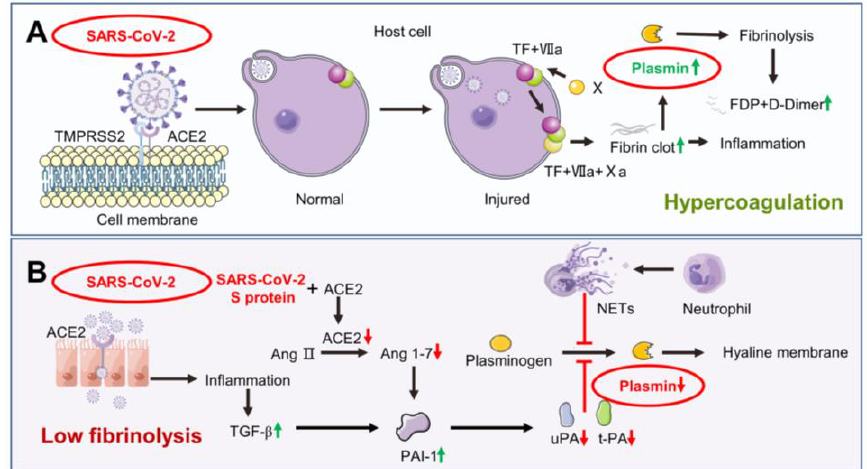
Figure 2. Possible process of coagulation and fibrinolysis in vivo during severe acute respiratory syn- drome coronavirus 2 (SARS-CoV-2) infection. ( A ) SARS-CoV-2 spike (S) protein binds to angiotensin- converting enzyme 2 (ACE2) receptors and facilitates virus invasion into host cells with the assistance of type II transmembrane serine protease (TMPRSS2). Injured host cells activate the coagulation cascade through TF-VIIa (tissue factor pathway) to promote fibrin production (hypercoagulable state). Overactivation of the fibrinolysis system results in increased plasmin production. Elevated plasmin degrades fibrin, leading to high D-Dimer levels and triggers a series of inflammatory reactions. ( B ) Activation of neutrophils and neutrophil elastase-associated DNA (NE-DNA) complexes formed by neutrophil extracellular traps (NETs) degrade plasminogen and inhibit its activation to plasmin. ACE2 receptor is internalized after binding to the SARS-CoV-2 S protein and fails to decompose angiotensin II (Ang II) into angiotensin1-7 (Ang1-7). Meanwhile, inflammatory reactions lead to increased transforming growth factor- β (TGF- β ) levels. Both Ang1-7 decrease and TGF- β elevation increases plasminogen activator inhibitor-1 (PAI-1), thereby inhibiting urokinase/tissue-type plas- minogen activator (uPA/t-PA) and plasminogen to plasmin (low fibrinolysis state), leading to the formation of a hyaline